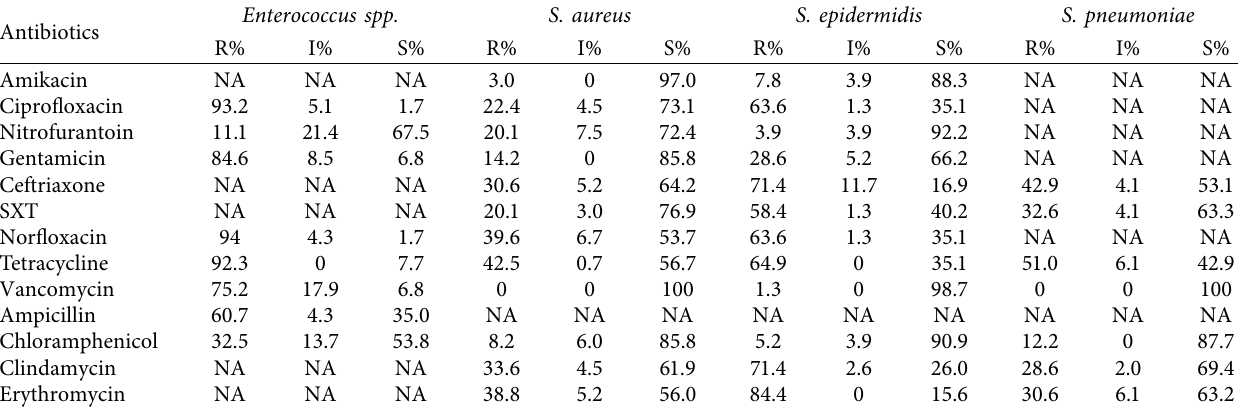
Table 4: Antibiotic resistance patterns of Gram-positive bacteria isolated from patients with infections. Enterococcus Antibiotics